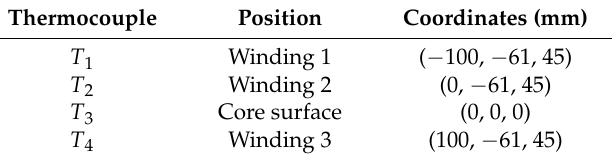
Figure 5. Thermocouple locations.